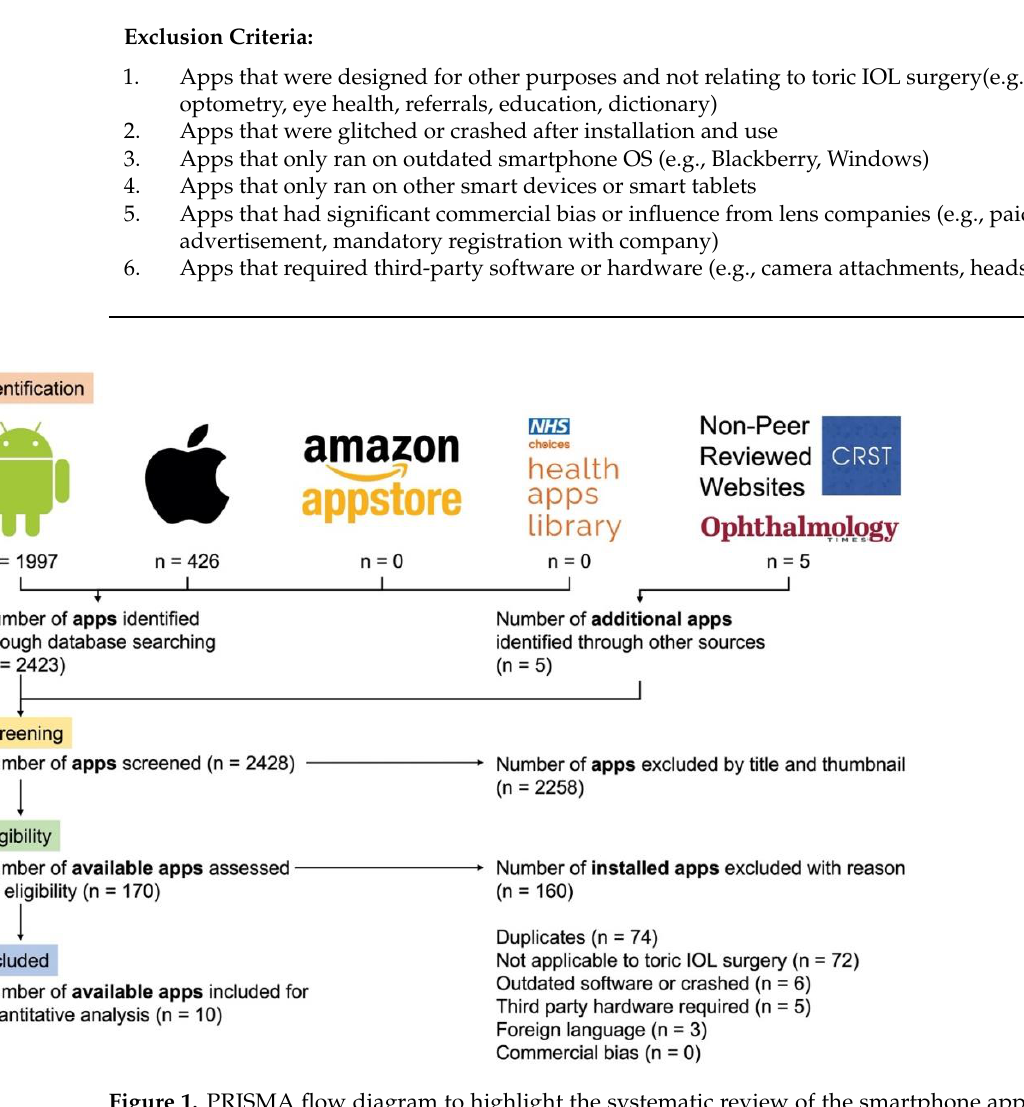
Figure 1. PRISMA flow diagram to highlight the systematic review of the smartphone app stores using keywords “toric lens”, “toric IOL”, “refraction”, “astigmatism”, “ophthalmology”, “eye calcu- lator”, “ophthalmology calculator” and “refractive calculator” in NHS Apps Library [18], Google Play Store [19], Apple App Store [20], Amazon Appstore [21] and non-peer-review ophthalmology websites [22 – 26]. Table 1. Inclusion and exclusion criteria for our systematic app search strategy. Inclusion criteria: